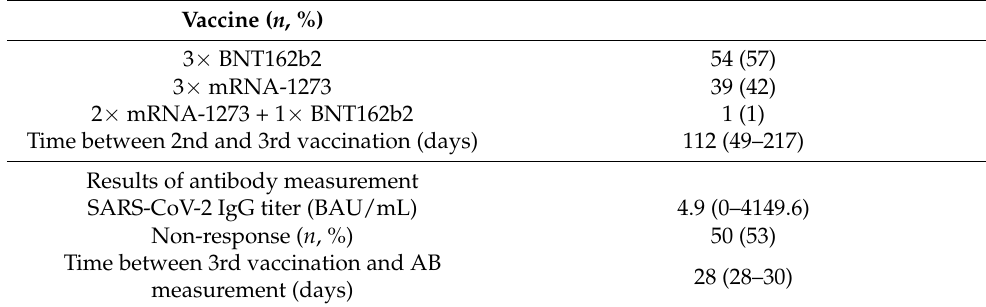
Table 2. Vaccination strategy and antibody measurements. Continuous data are displayed as median and 25% and 75% percentiles. Numerical data are displayed as number of participants ( n ) and percentage (%) where appropriate (sums do not add up to 100% due to rounding).